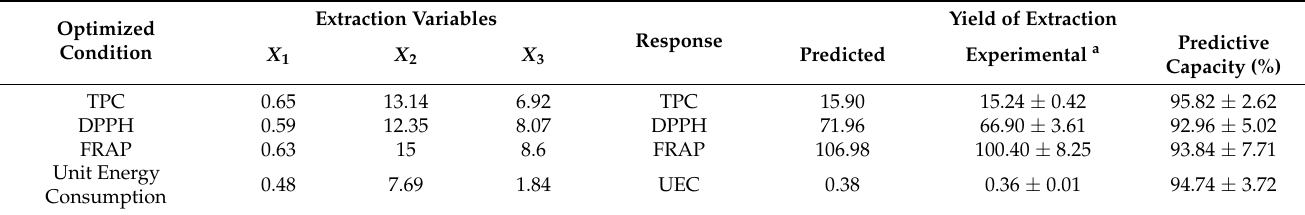
Table 5. Comparison between the empirical and estimated values of total phenolic content, DPPH, FRAP and unit energy consumption determined in the optimized